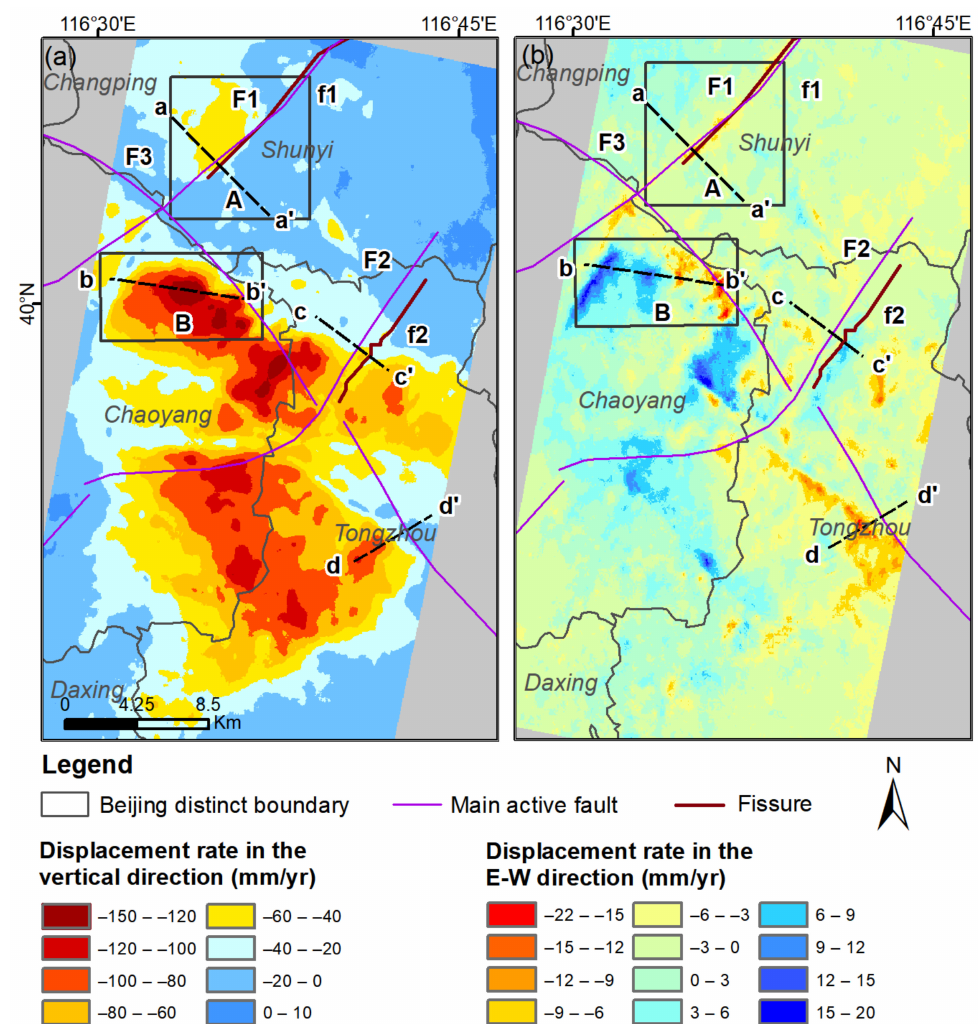
Figure 7. Surface displacement maps from 2016 to 2018 by using ascending and descending SAR data: ( a ) vertical component of the displacement field; ( b ) east–west component of the displacement field. (f1: Shunyi fissure; f2: Songzhuang fissure. A: Beijing Capital International Airport (BCIA); B: Jinzhan. F1: Shunyi–Liangxiang fault. F2: Nanyuan–Tongxian fault. F3:Nankou–Sunhe fault. a–a’, b–b’, c–c’, d–d’ are the displacement profiles within depressions are marked by black dashed